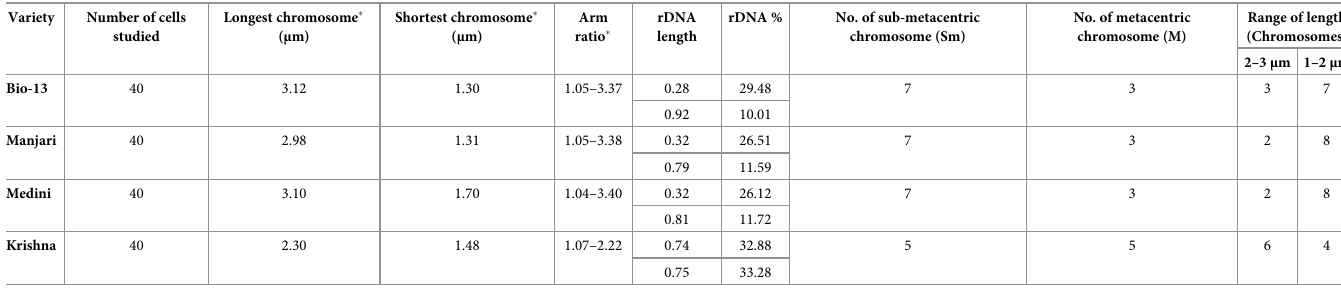
Table 1. Description of karyotyping in all the